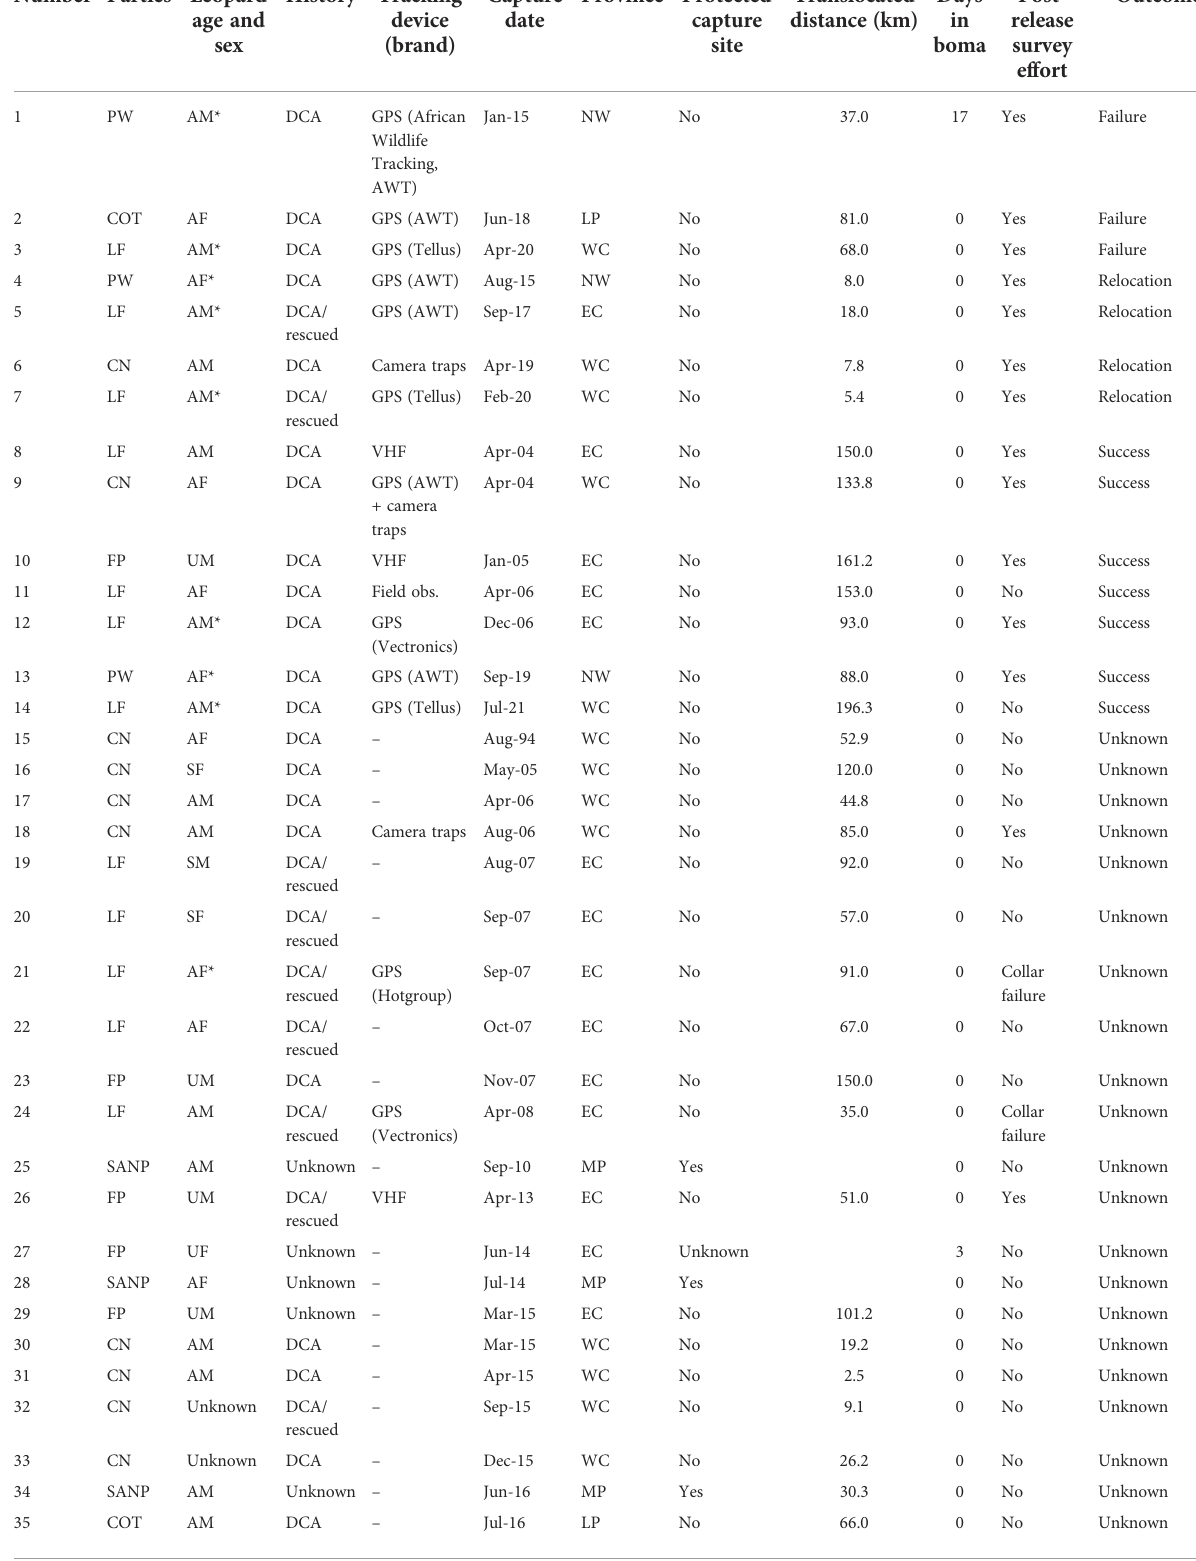
TABLE 1 Biological and technical details relevant to the 60 translocation events across South Africa. Number Parties Leopard age